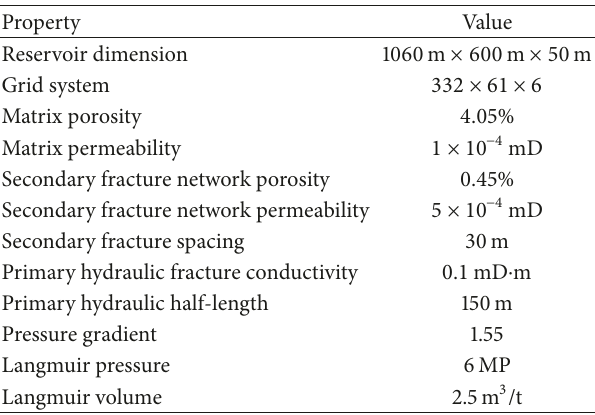
Table 1: Key properties of shale reservoir